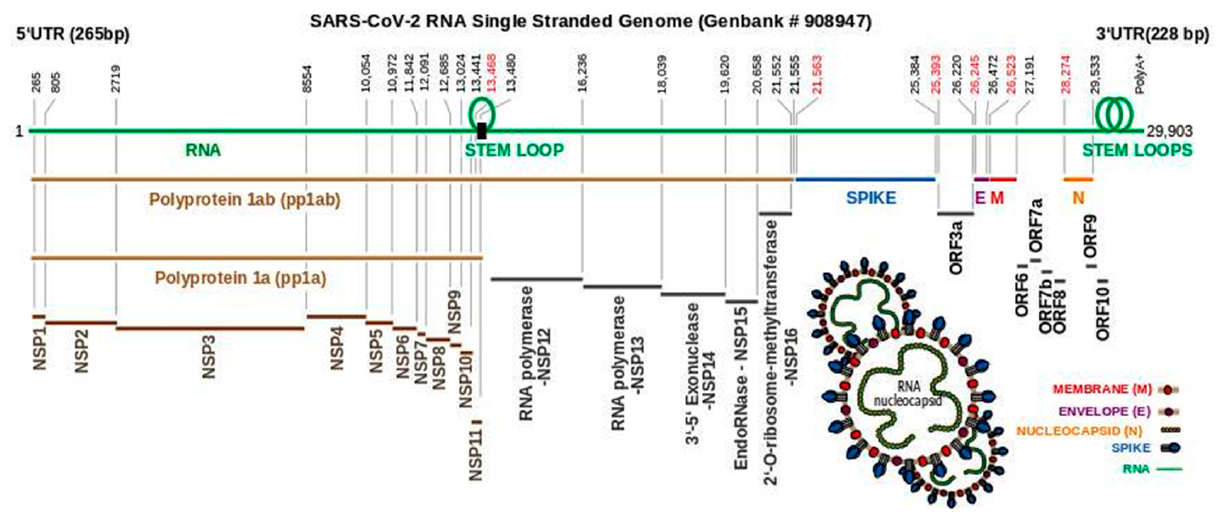
Figure 1. Schematic overview of the SARS-CoV-2 single stranded RNA genome. Upper line (green) represents the Severe Acute Respiratory Syndrome Coronavirus 2 isolate Wuhan-Hu-1 accession number NC_045512 version 2 entry in the National Centre for Biotechnology Information database. Numbers (black) represent the beginning and end of a coding region. Of note, coding regions do not run consecutively (numbers in red). Polyproteins 1ab (pp1ab) and 1a (pp1a) are translated from ORF1ab (265–21,555 bp) via a ribosomal slippage site (black rectangle) and stem loop formation. Non- structural proteins (NSP 1–11) are cleaved from both polyproteins. Cleavage of NSP12–16 occurs only from pp1ab enabling the formation of various listed enzymes. Structural proteins spike (S), envelope (E), membrane (M) and nucleocapsid (N) are encoded by the genes S (21,563–25,384 bp), E (26,245–26,472 bp), M (26,523–27,191 bp), and N (28,274–29,533 bp). Open reading frames (ORF) ORF3a, 6, 7a, 7b, 8, 9, and 10 are encoded by intermediate genomic segments as indicated. The location of two stem loops is shown adjacent to the 3 (cid:48) UTR representing pseudoknot stem loop (left) and s2m (right). The overall structure of SARS-CoV-2 is illustrated with abbreviations as indicated